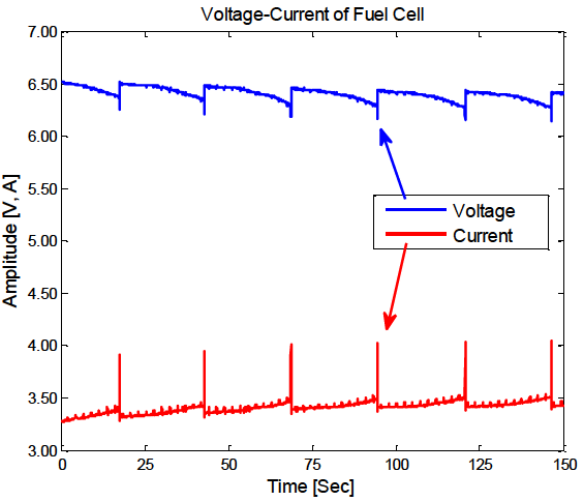
Figure 2: Current [A] and Voltage [V] variations of the Fuel Cell Sys- tem.